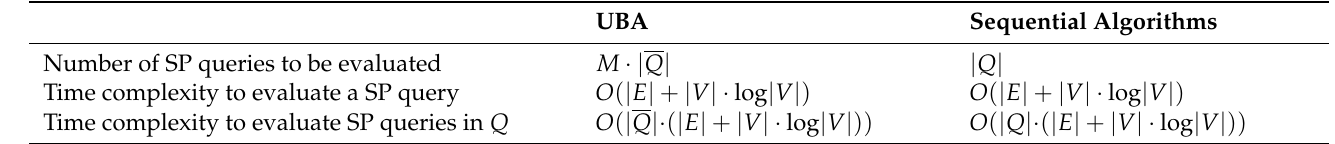
Table 2. Comparison of time complexities of UBA and sequential algorithms.